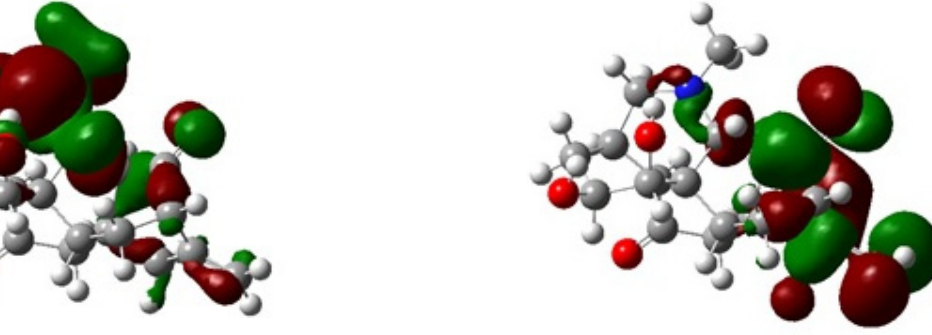
Figure 5. Structure of Compound 1 , orientation of different rings and groups are shown accordingly.